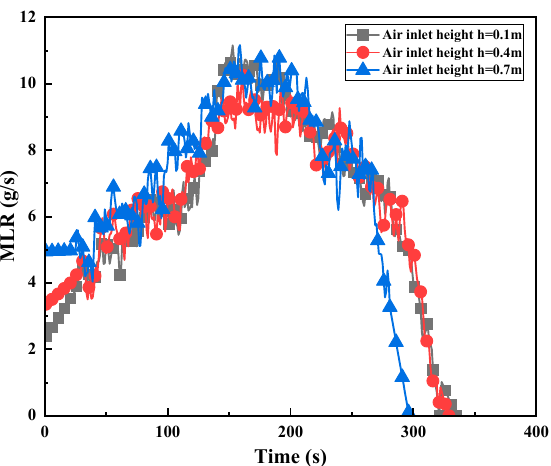
Figure 4. Variation in mass loss rate with time under different air supply inlet heights. The mass loss rate is time-averaged, and the forced air volume and mass loss rate are dimensionless based on the experimental results in Figure 3 and the experimental results of predecessors [7]. The dimensionless mass loss rate 𝑚(cid:4662) ∗ can be defined as 𝑚(cid:4662) ∗ = 𝑚(cid:4662) /𝑚(cid:4662) (cid:3047)(cid:3035) , where 𝑚(cid:4662) is experimental mass loss rate, 𝑚(cid:4662) (cid:3047)(cid:3035) is the mass loss rate of the oil pool of di- ameter D in the free atmosphere, 𝑚(cid:4662) (cid:3047)(cid:3035) = 𝑚(cid:4662) (cid:2998)(cid:4593)(cid:4593) (1 − 𝑒 −𝑘𝛽𝐷 )𝐴 𝑓 . The number of air changes N can be defined as 𝑁 = 3600𝑉 (cid:3046) /𝑉 (cid:3030) , where 𝑉 (cid:3046) is the supply air volume, 𝑉 (cid:3030) is the cabin volume. By introducing a dimensionless length 𝑓(𝐷, 𝑉 (cid:3030) ) = 𝐷 ∙ 𝑉 (cid:3030)(cid:2879)(cid:2869)/(cid:2871) , the relationship be- tween the dimensionless mass loss rate and the number of air changes in this experiment and previous research results can be drawn on a graph, as shown in Figure 5. It can be seen from the figure, under the conditions of the experimental cabin and ventilation con- figuration, that the fire source mass loss rate and the supplementary air volume have the following relationship: